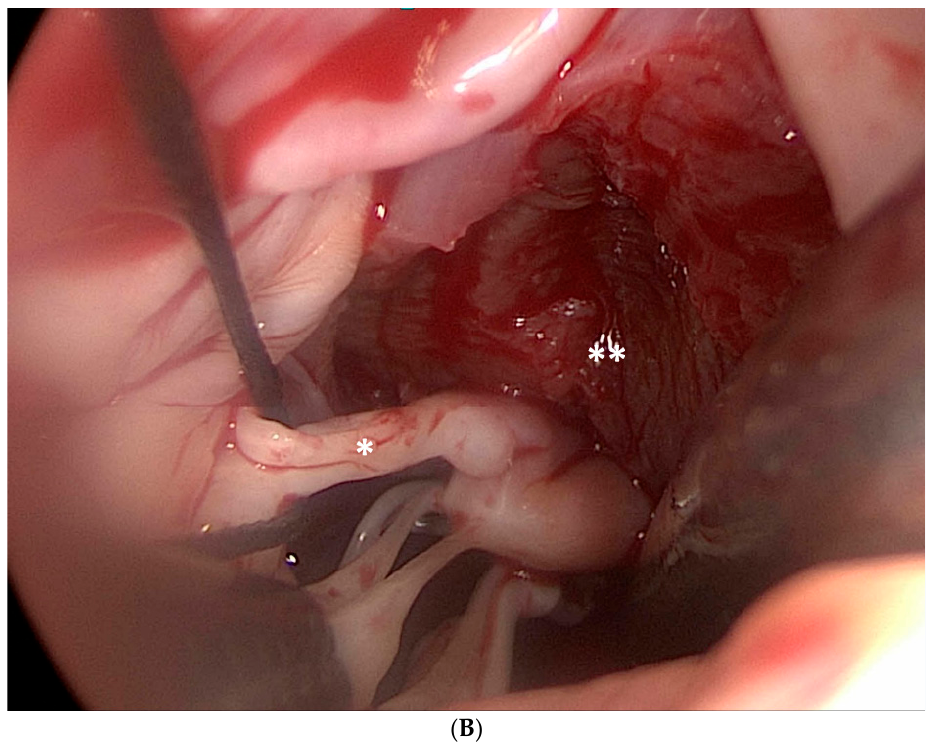
Figure 6. Surgical myectomy ( * ) was performed starting at the nadir of the right coronary sinus, and extended apically to achieve the exposure of the papillary muscles. MV: mitral valve ( A ). Surgical view of the diseased mitral valve secondary cordae (*) and papillary muscles (**) after myectomy. It is noteworthy that the bases of the papillary muscles are now visible ( B ).